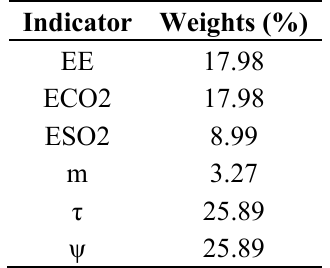
Table 5. Final relative significance weighting of determined indicators.